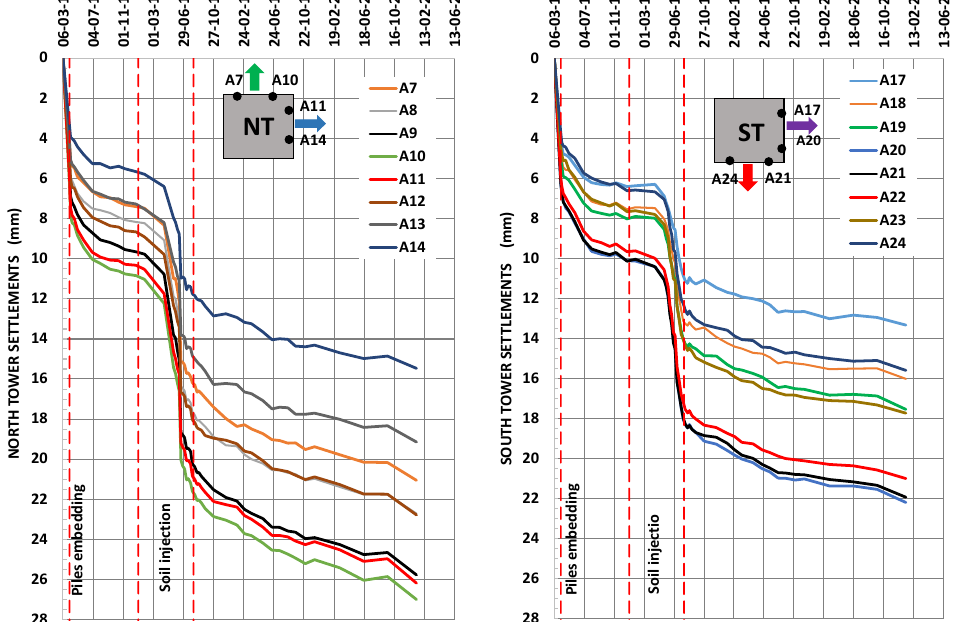
Figure 26. Diagrams of geodetic markers settlement during and after remediation works .